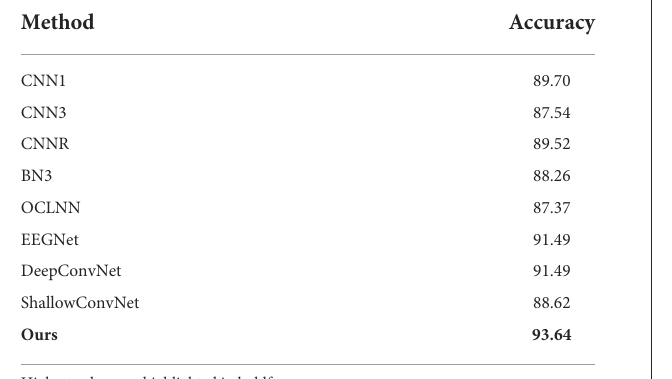
TABLE 5 Classification accuracy ( % ) on BCI competition II dataset.